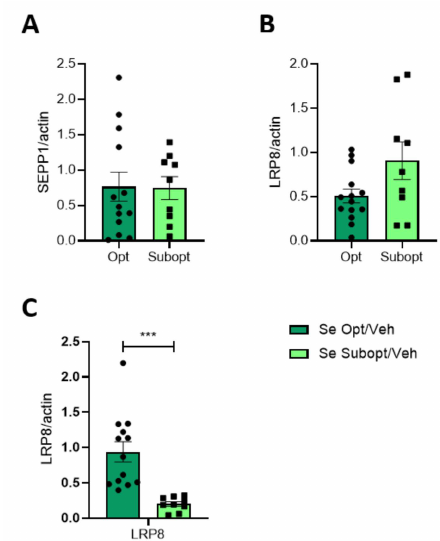
Figure 6. Effect of Se diet on selenoprotein and Se transporter protein expression in juvenile rats. Protein expression of SEPP1 ( A ) and LRP8 ( B ) in the homogenate and TIF (LRP8, ( C )) of PND 23 hippocampi of rats fed with optimal versus suboptimal Se diet. Data are shown as individual value plots and are represented as ratio on actin levels ( n ≥ 9); Unpaired t -test, *** p <